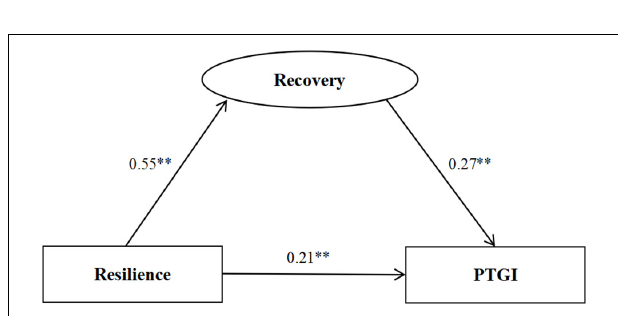
FIGURE 3 | Standardized solution for the structural equation model of resilience, recovery, and posttraumatic growth. ∗∗ Significant at the 0.01 level